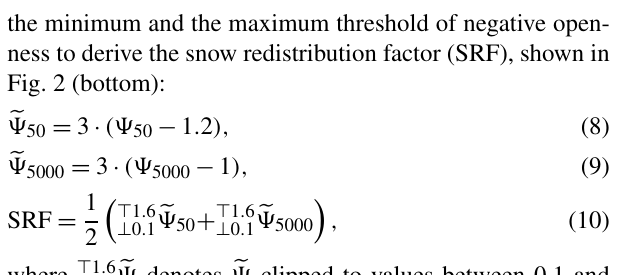
the minimum and the maximum threshold of negative open- ness to derive the snow redistribution factor (SRF), shown in Fig. 2